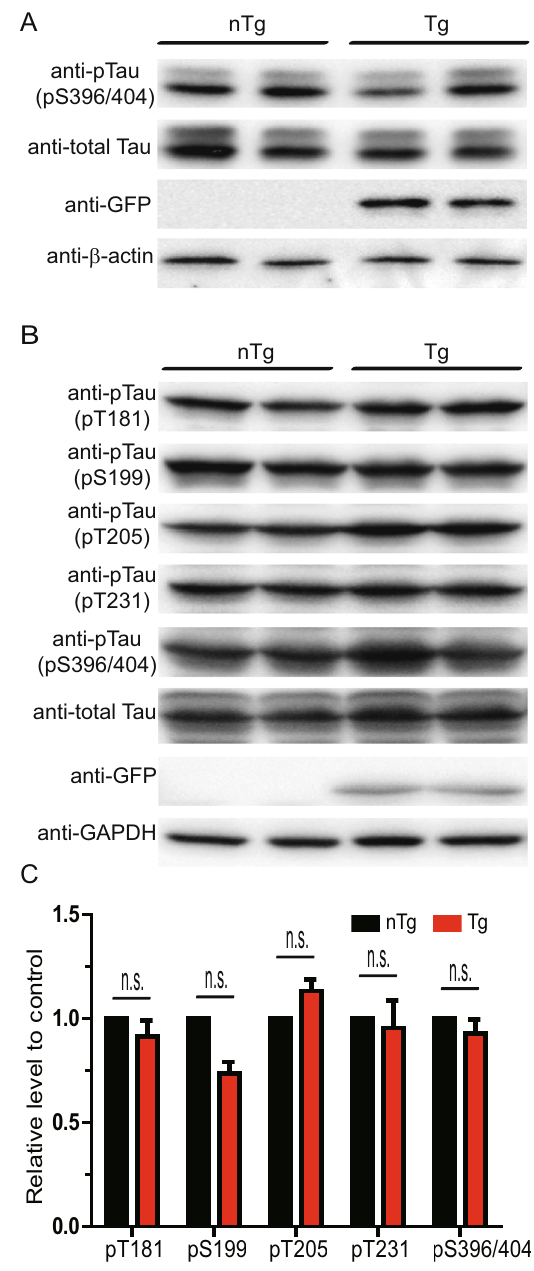
Figure 2. No increase pTau species was detected in Line 78 E18 neurons and embryos. E18 cortical neurons from mouse cortical neurons from Line 78 transgenic embryos and nontransgenic littermates were cultured in 12 well plates. Neurons were collected at DIV4 and protein lysates were generated and analyzed by SDS-PAGE/ immunoblotting with antibodies indicated ( A ). In B , brain homogenates from 8 month-old Line 78 transgenic embryos or non-transgenic littermates were analyzed using indicated specific antibodies as in A . In C , the protein levels of pTau were quantitated and expressed as percentage of change relative to changes observed in control mice. No significant changes were seen between transgenic and non-transgenic samples. At least three independent experiments were performed for all the studies presented. All original, full size, uncut blots are presented in Supplemental